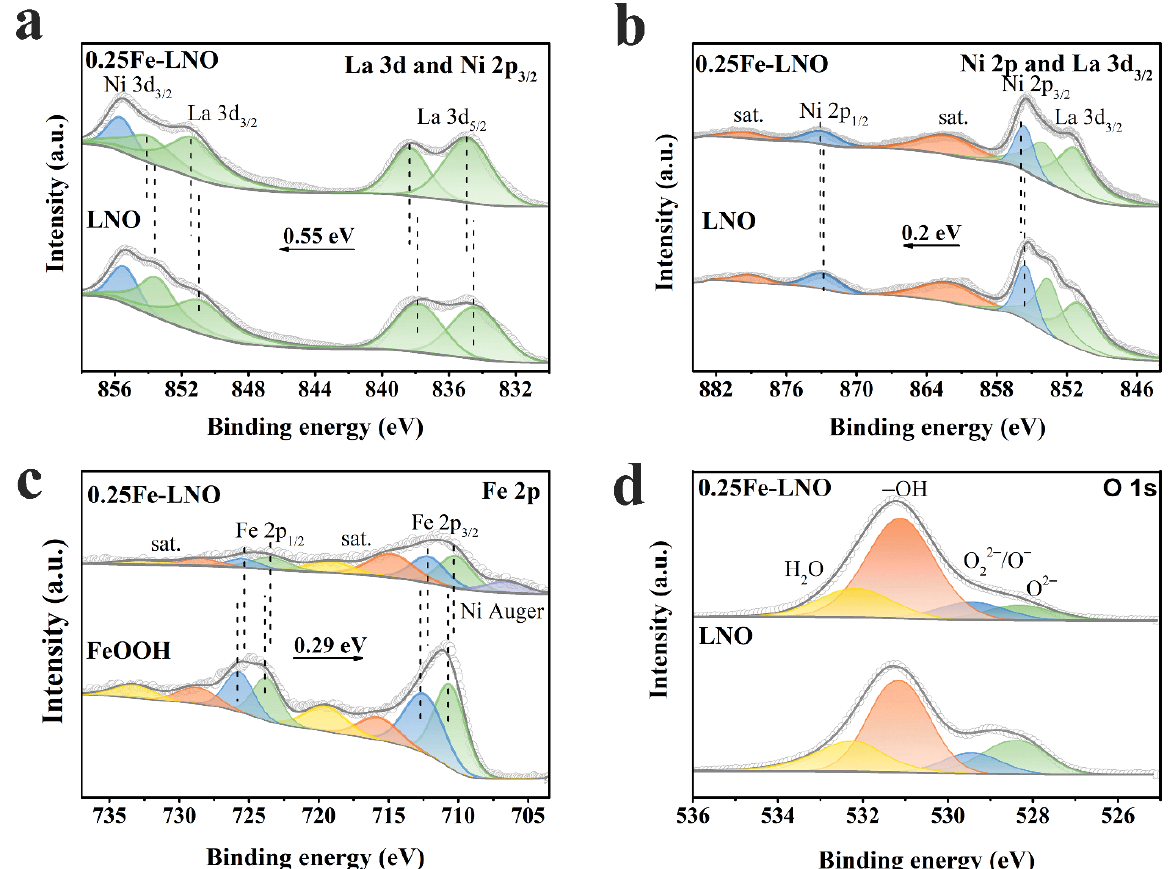
Figure 3. XPS spectra of ( a ) La 3d, ( b ) Ni 2p, ( c ) Fe 2p and ( d ) O 1s.